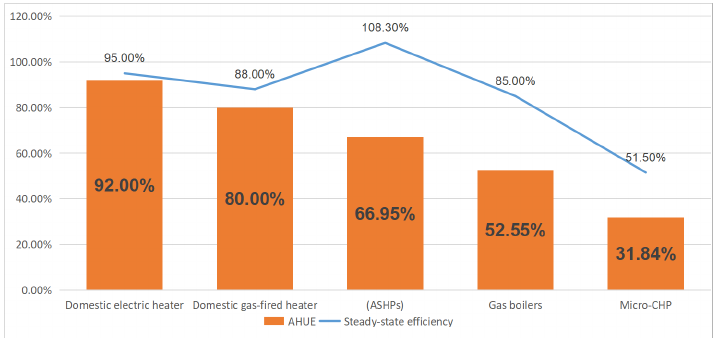
Figure 3. AHUE and steady-state efficiency in DHW system of the building.